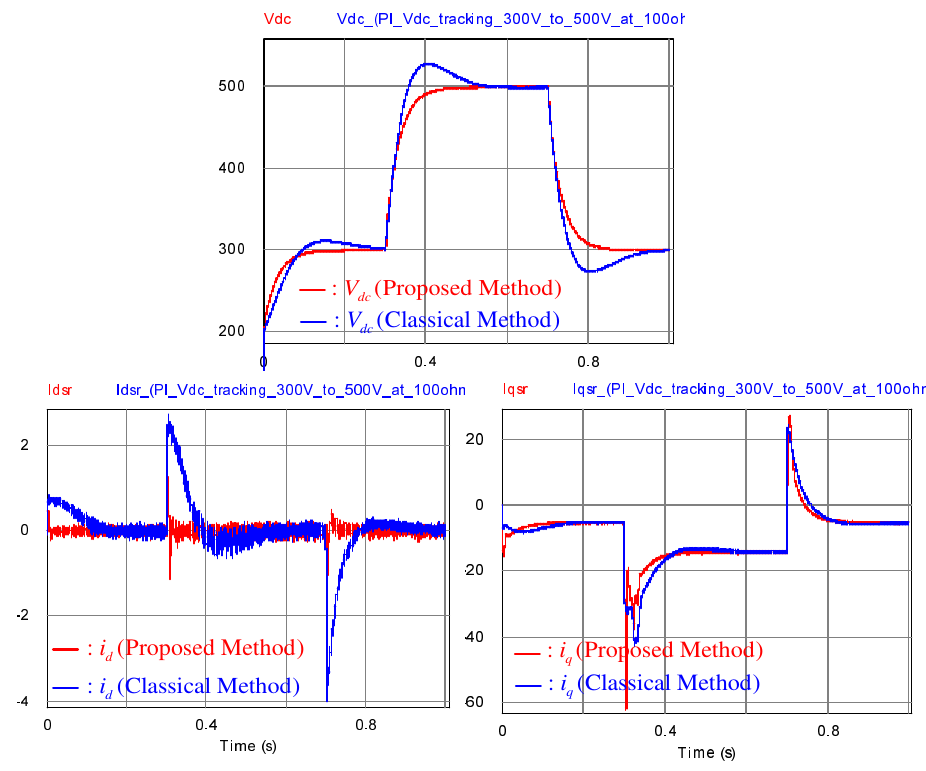
Figure 3. The closed-loop performance comparison between the proposed method and the feedback linearizing (FL) method with a resistive load of R L = 100 Ω